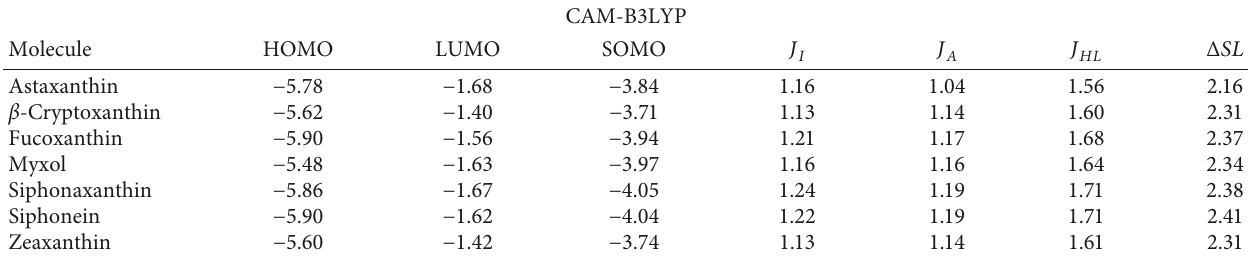
Table 4: HOMO, LUMO, and SOMO orbital energies (in eV) and the KID-related descriptors obtained with the five density functionals, the Def2TZVP basis set, and water as the